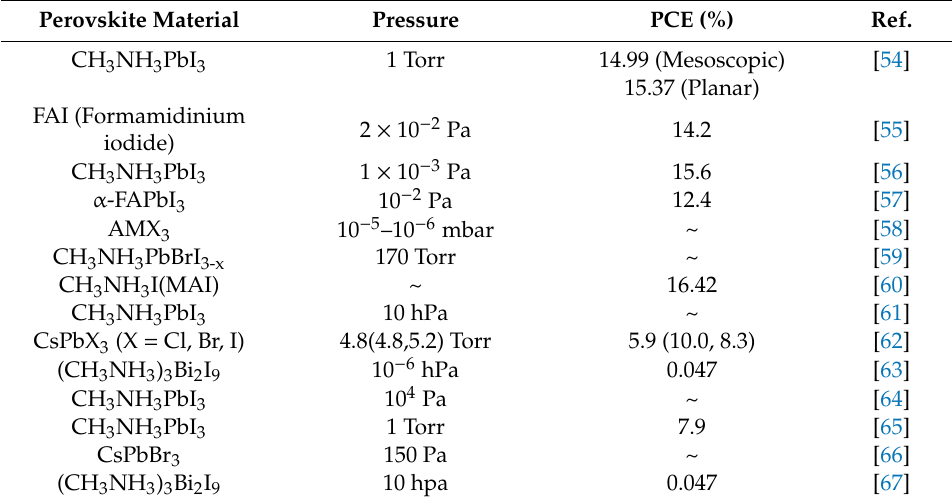
Figure 3. Schematic diagram of LPCVD instrument. Reproduced with permission from reference [34]. Table 2. Perovskite materials were synthesized by LPCVD technique